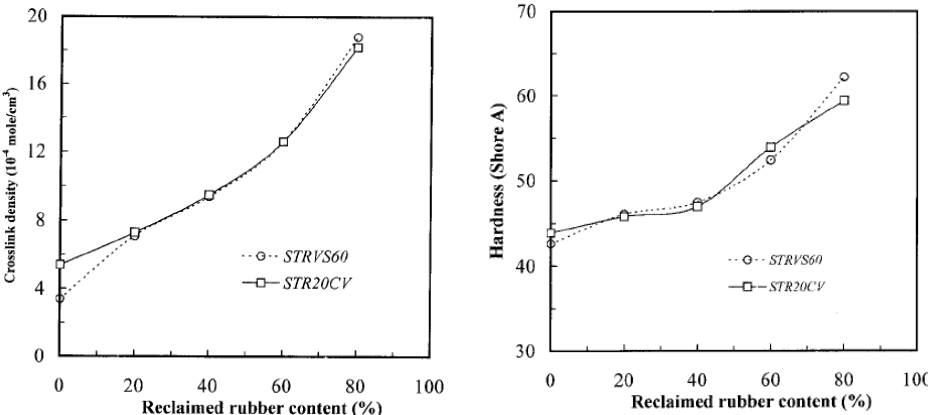
Figure 32. Crosslink density ( left ) and hardness ( right ) of NR/RTR compounds as a function of RTR content (reproduced with permission from [122]).